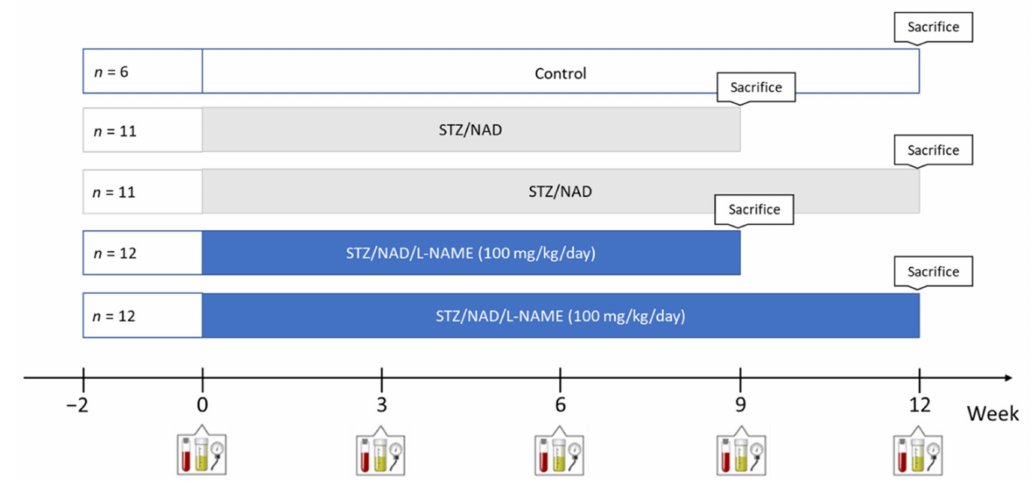
Figure 9. Study setup. Created with